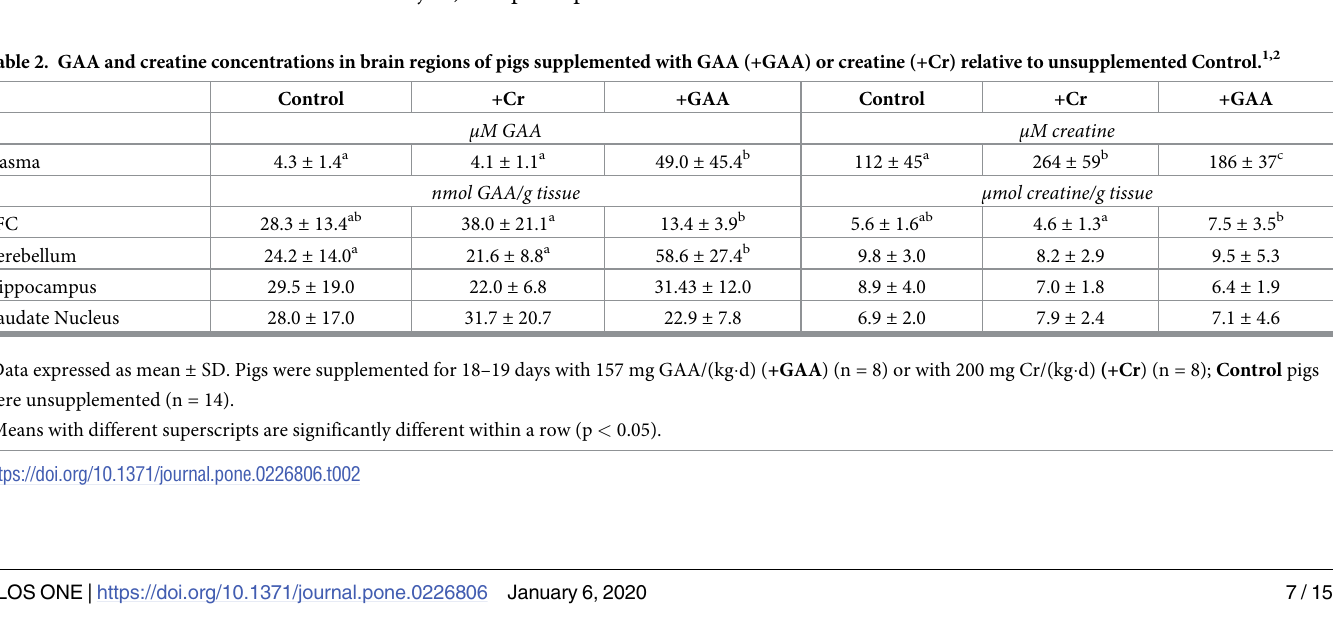
Table 2. GAA and creatine concentrations in brain regions of pigs supplemented with GAA (+GAA) or creatine (+Cr) relative to unsupplemented Control. 1,2